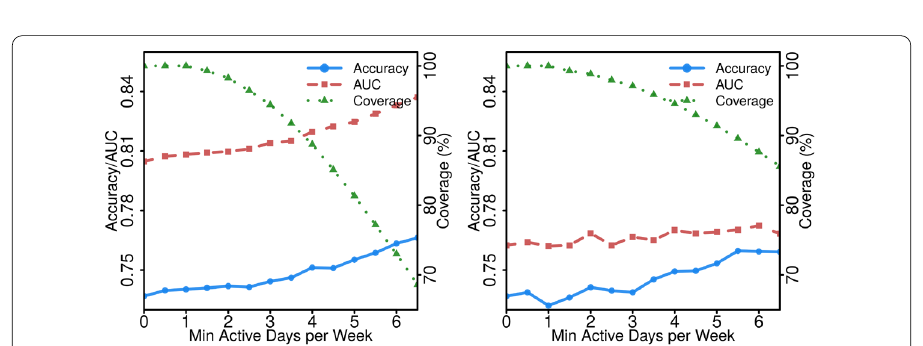
Figure 3 Accuracy and AUC in EU (left) and SA (right) as a function of the minimum required level of activity. The model is trained and tested on a subset of users who are on average active x days per week, throughout the 3-months CDR period. As we increase this minimum required threshold, x, the coverage decreases and the performance slightly improves.